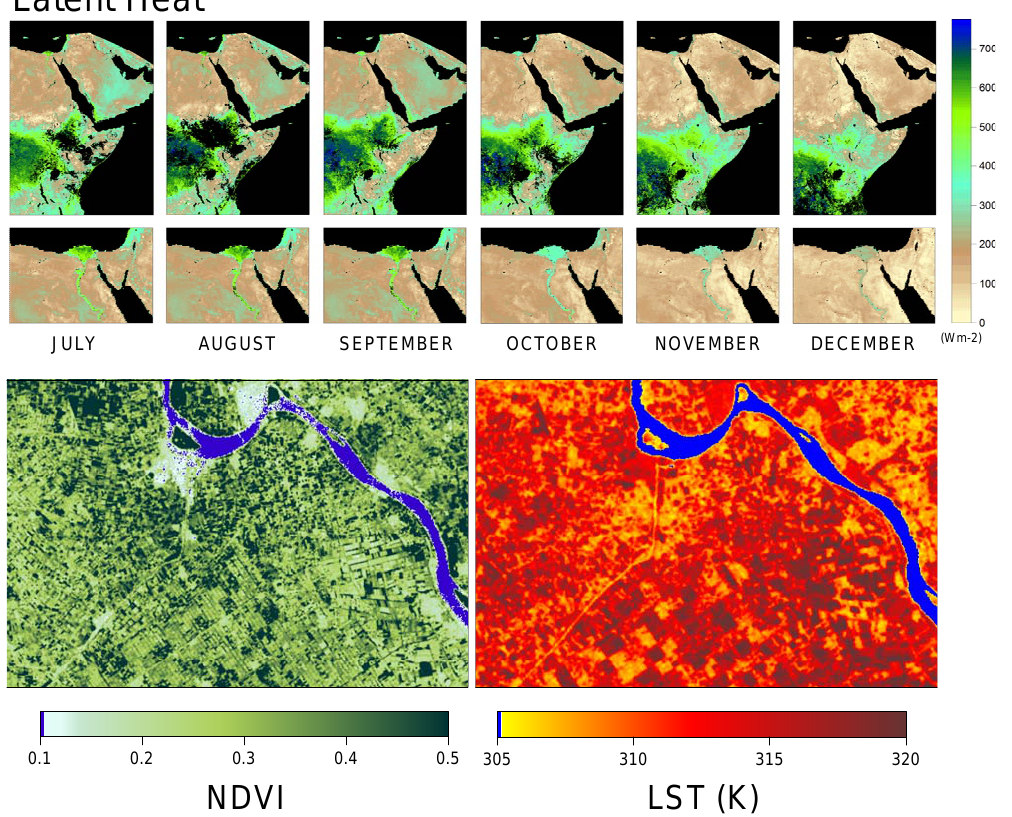
Fig. 11. Monthly composites of clear-sky latent heat flux (instantaneous, shortly before local noon) for 2008 over the Nile River Basin, generated at 6-km resolution by ALEXI using MSG land-surface products (top row). Blanked areas were perpetually cloud-covered. Also shown for resolution comparison are Landsat-7 maps of NDVI (30-m resolution) and LST (60-m) for a sub-region in the Nile Delta for 1 June